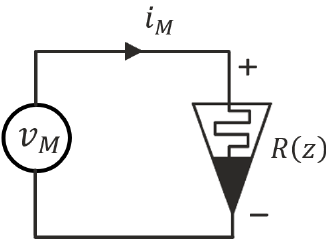
Figure 6. The symbolic diagram of the fractional-order memristor.